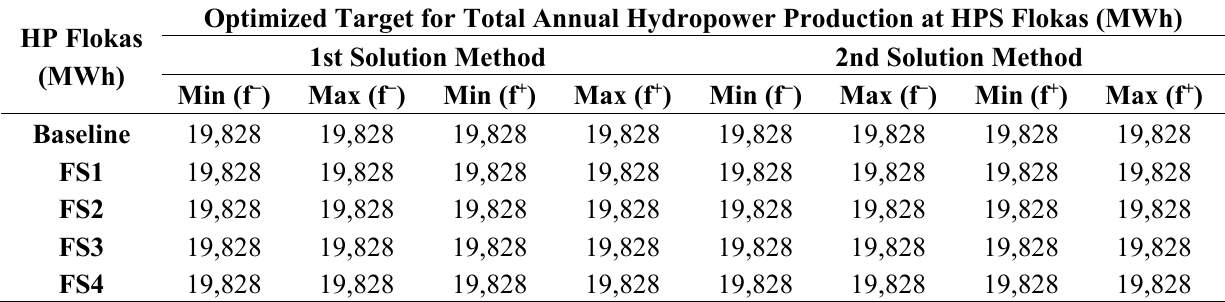
Table 16. Optimized target for total annual hydropower production at HPS Flokas